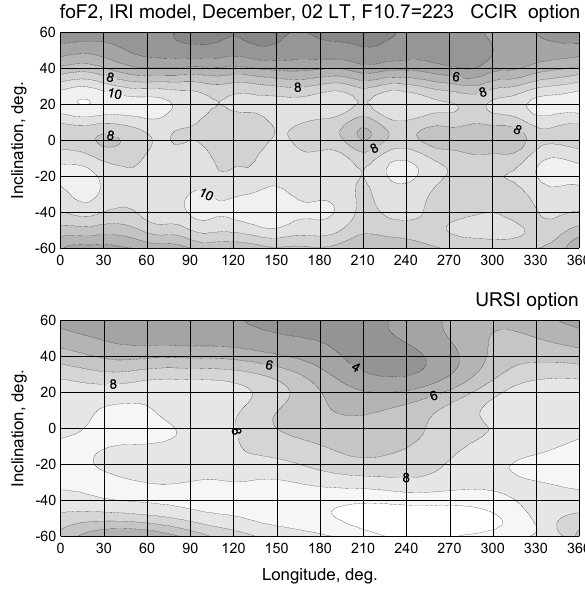
Fig. 9. IRI fo F2 maps with URSI and CCIR coefficients for 03:00 LT in the June solstice. Fig. 10 to the manuscript by G.F. Deminova "Maps of foF2, hmF2, ..."